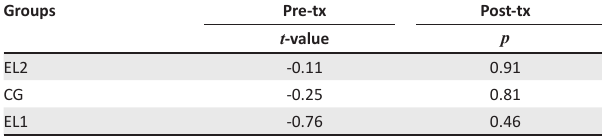
FIGURE 3: Average scaled scores of phonological blending of all participants across all groups. TABLE 5: Results of t -tests for significant differences in pre- and post-intervention phonological blending scores within groups.